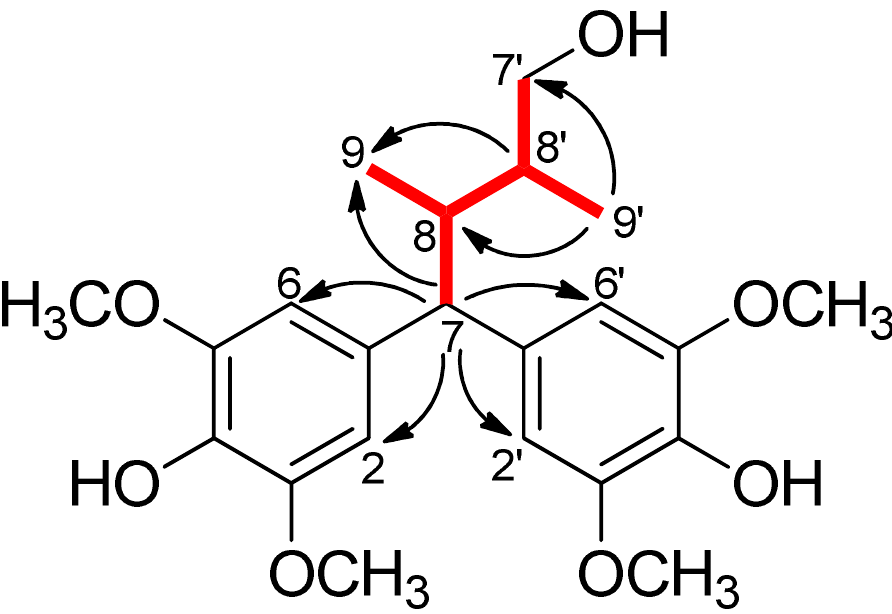
Figure 3. Selected 1 H- 1 H COSY ( — ) and HMBC ( → ) correlations of 9 .